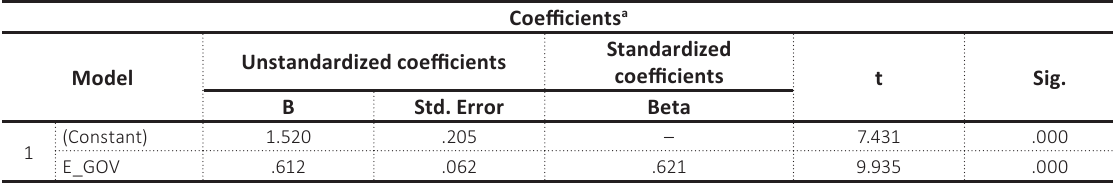
Table 8. Coefficients of the impact of e-government on job